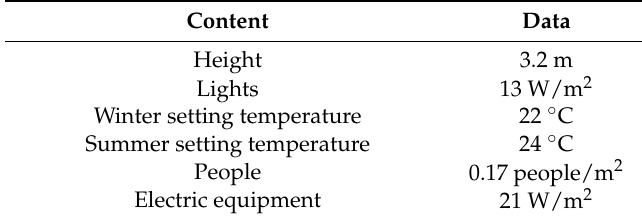
Table 3. Production information of the biogas.